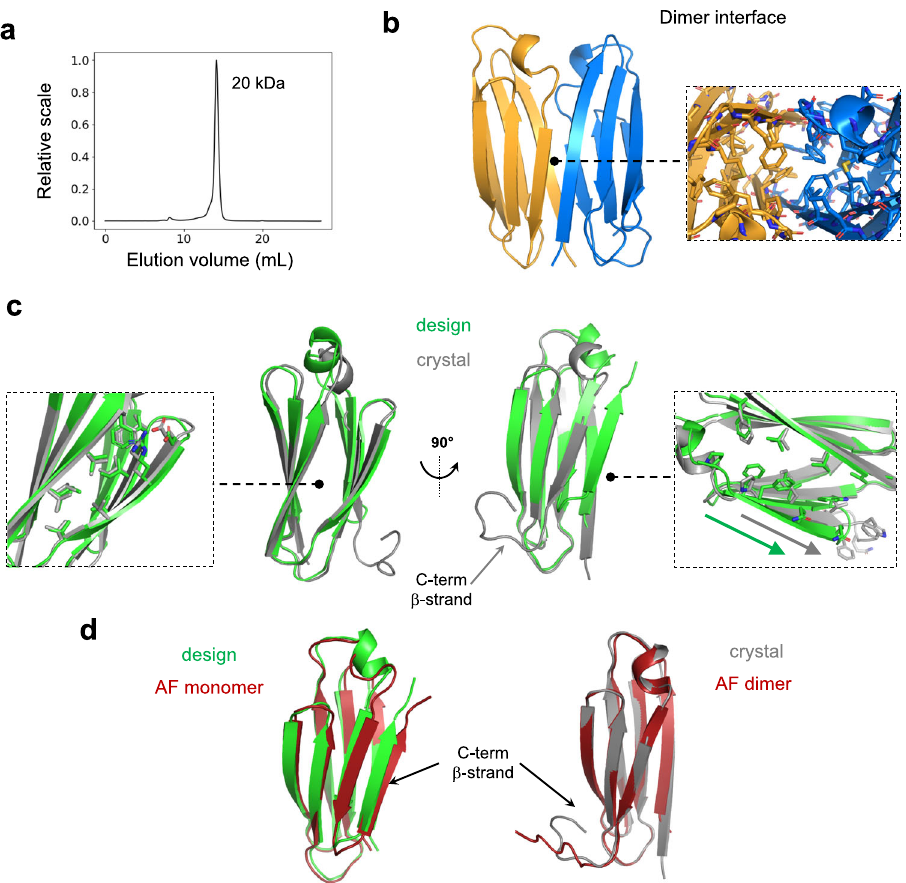
Fig. 4 | Crystal structure of the dIG14 dimer. a SEC-MALS analysis of dIG14 esti- mates a molecular weight corresponding to a dimer (M w monomer=9.7kDa). b Crystal structure of the homodimer interface formed by antiparallel pairing between β -strands 1 and 6 enabled by fl ipping out of the C-terminal β -strand; the monomer core becomes more accessible and the interface is primarily formed by hydrophobic contacts (right inset). PDB accession code of the dIG14 crystal structure: 7SKP. c dIG14 design model (green) in comparison with the crystal